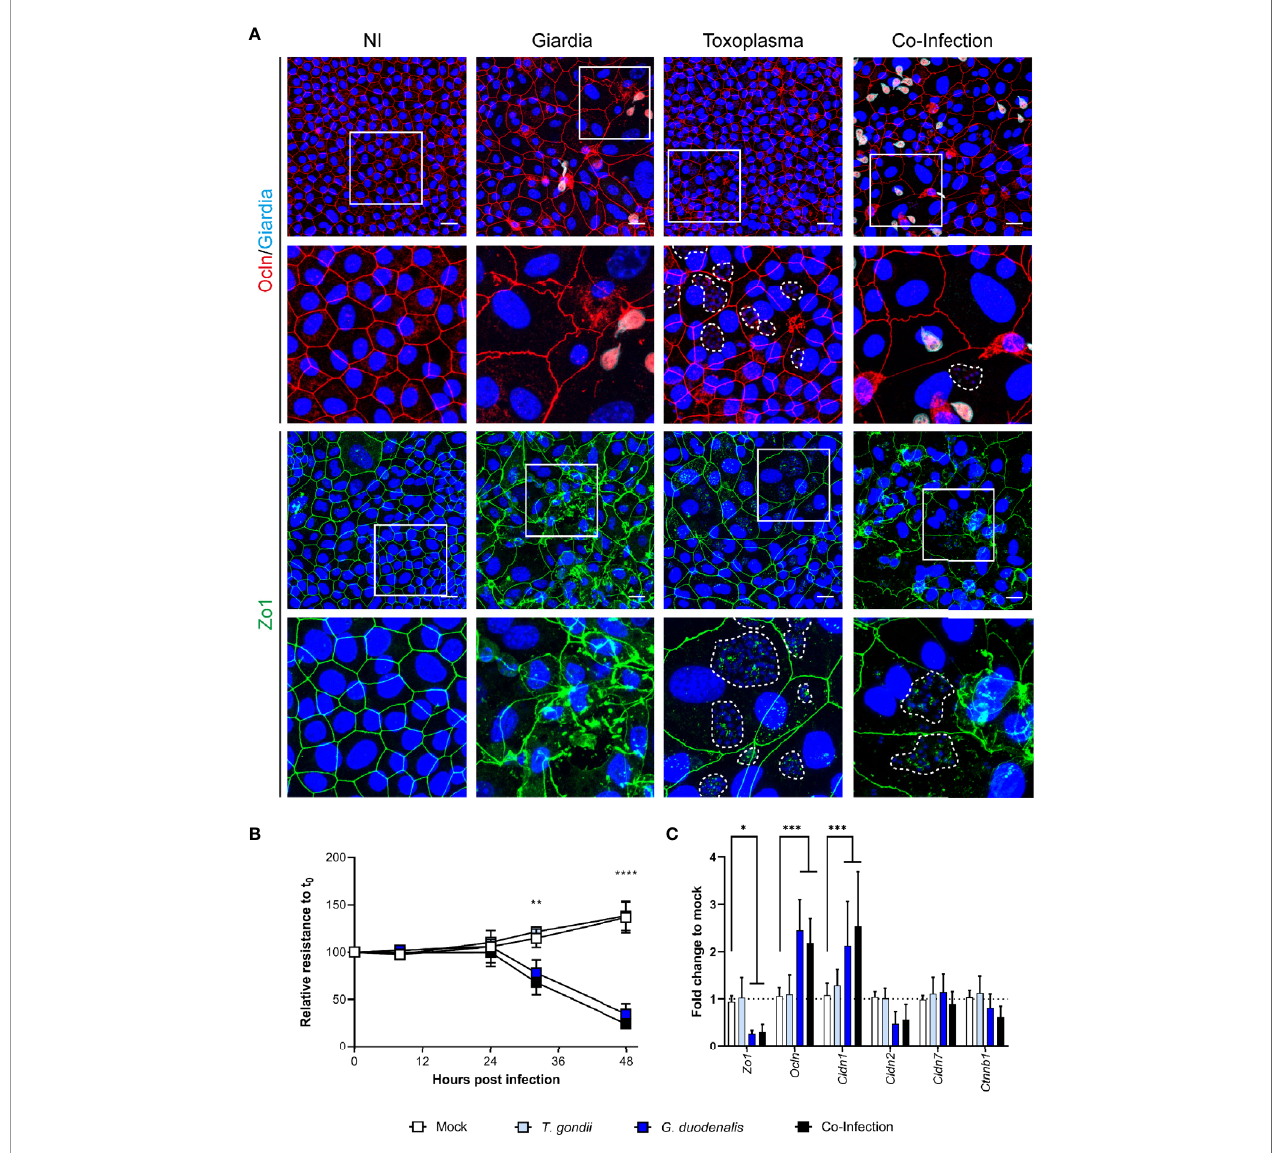
FIGURE 6 | Co-infection of murine ODMs with T. gondii and G. duodenalis . Murine ODMs were infected with either an ID of 3 ( G. duodenalis strain WB6 trophozoites) or an ID of 25 ( T. gondii strain RH tachyzoites), or both and monitored for 48 h post infection. (A) Representative projections of immuno fl uorescence Z- stack images of Zo-1 and occludin of non-infected (NI), G. duodenalis, T. gondii and co-infected murine ODMs after 48 h. T. gondii ’ s mitochondrial GFP fl uorescence was lost due to methanol fi xation; instead, dashed lines indicate T. gondii vacuoles including parasite nuclei (blue). Scale bars represent 20 µm. All experiments were performed twice with similar results (B) TEER monitoring of infected murine ODMs. Data are presented as mean (± 95% CI) of four independent experiments with three fi lters per experiment. Statistical signi fi cance between infection and mock controls was determined using a Two-Way ANOVA with Dunnett ’ s correction for multiple testing. **p < 0.01, ****p < 0.0001 (C) Transcriptional changes of indicated tight junctional components in infected ODMs. Data are presented as mean (± 95% CI) of three independent experiments with three fi lters per experiment. Statistical signi fi cance was determined using a Two-Way ANOVA with Dunnett ’ s correction for multiple testing. *p < 0.05, ***p <